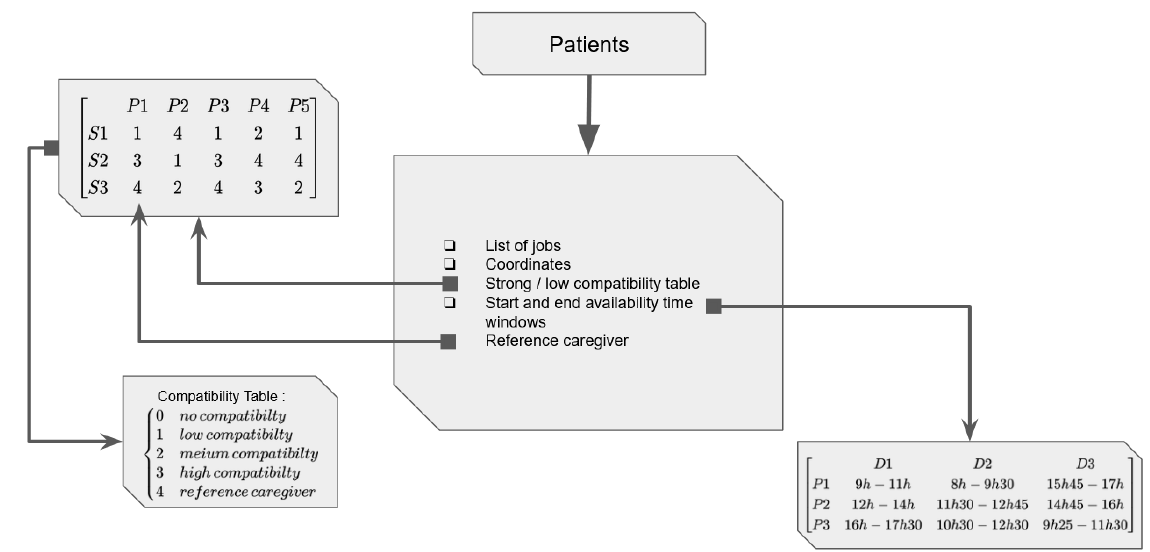
Figure 7. Description and summary of a